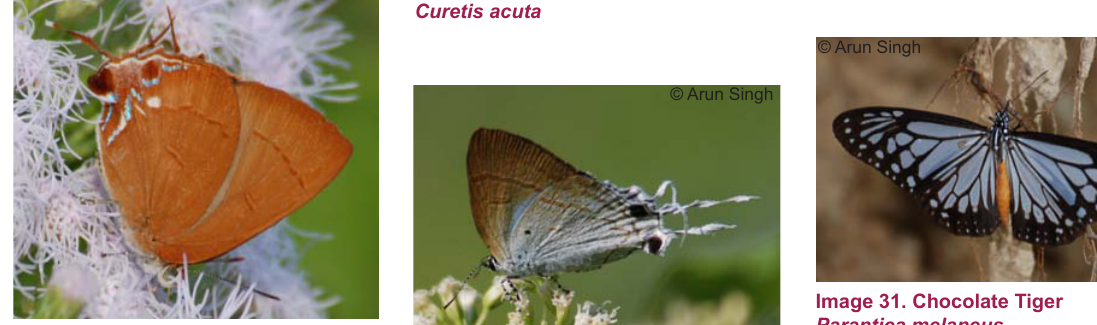
Image 29. Chocolate Royal Eliotia jangala